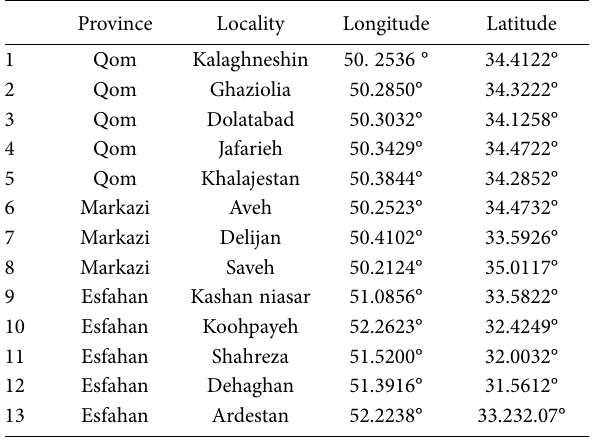
Table 1. Ziziphus jujuba population in ISSR and SRAP